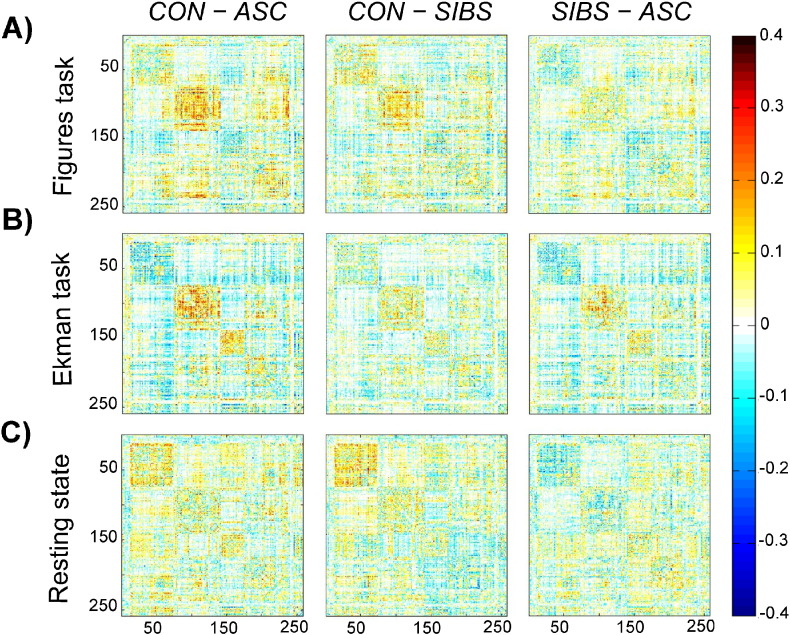
Difference matrices produced by subtracting the connection weights of one group from another. The 258 × 258 matrices reflect the edges (connections) between 258 brain nodes. White voxels reflect connections where groups do not differ in connection weights. Red voxels represent connections which are stronger in the first group than the second (controls > ASC; controls > siblings; siblings > ASC). Blue voxels represent connections which are stronger in the second group than the first (ASC > controls; siblings > controls; ASC > siblings).